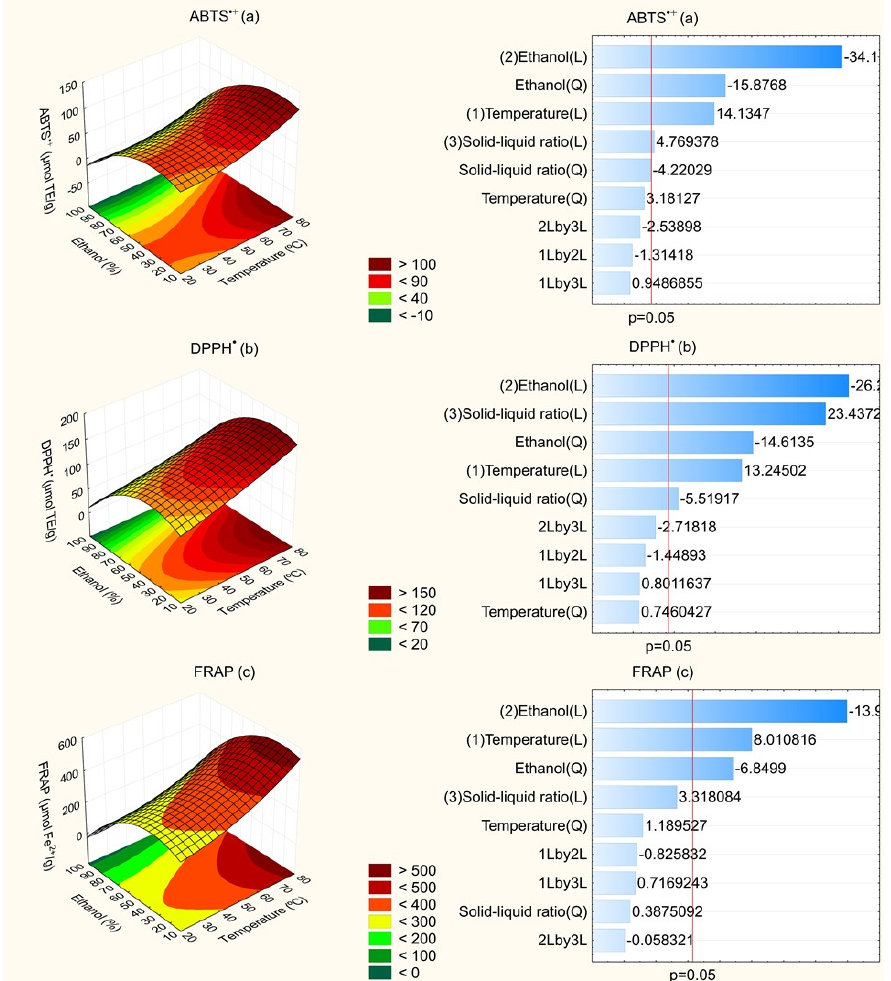
Figure 2. Effect of the independent variables on the antioxidant capacity by ABTS •+ ( a ), DPPH • ( b ) and FRAP ( c ) assays.